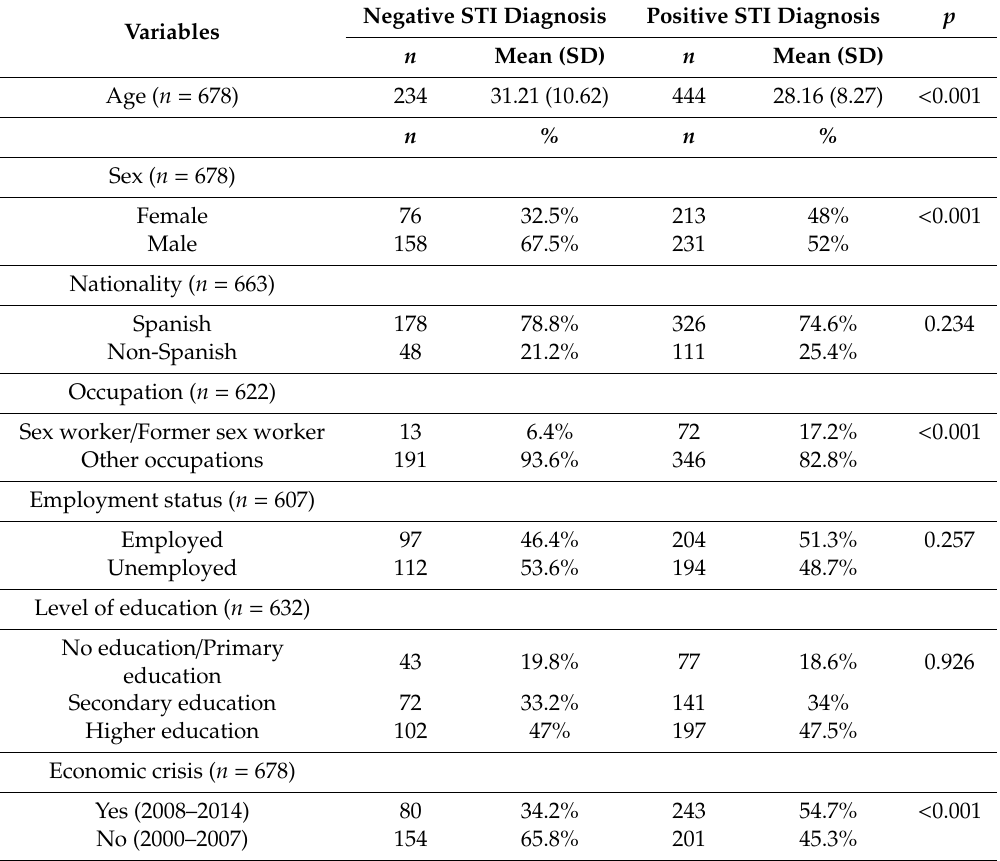
Table 1. STI diagnosis vs. sociodemographic characteristics.